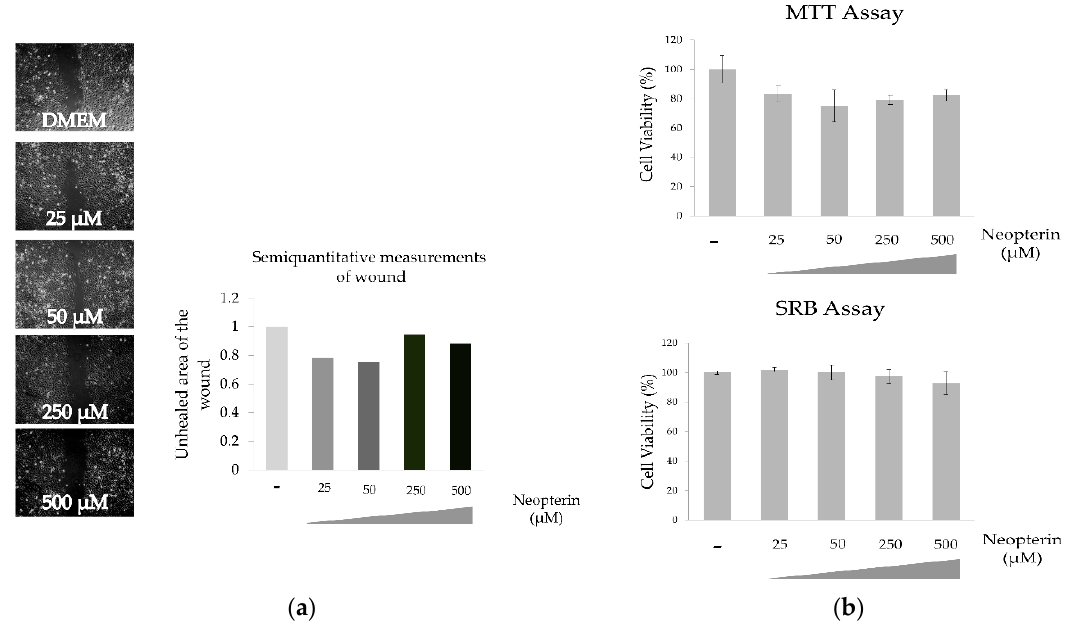
Figure 2. Effect of neopterin on wound healing ( a ) and cytotoxicity ( b ) of PLC/PRF/5 cell line.